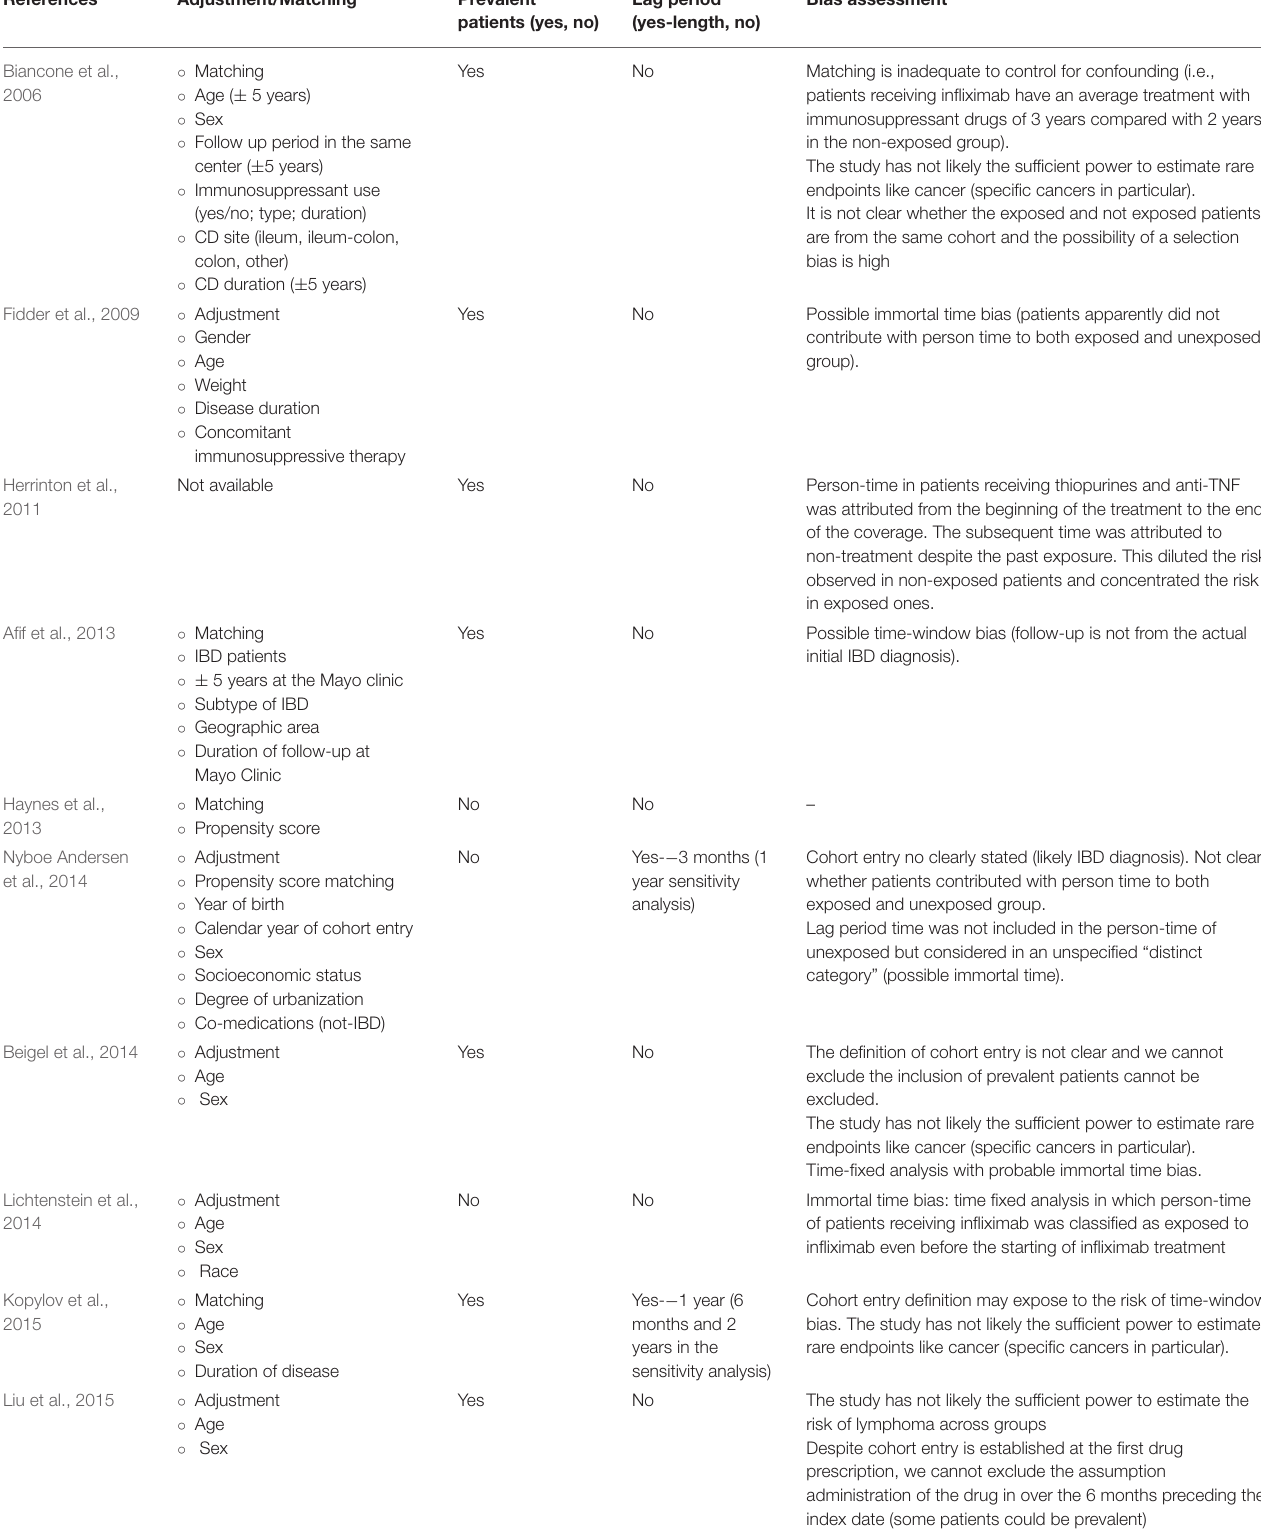
TABLE 3 | Methodologic features of the elected